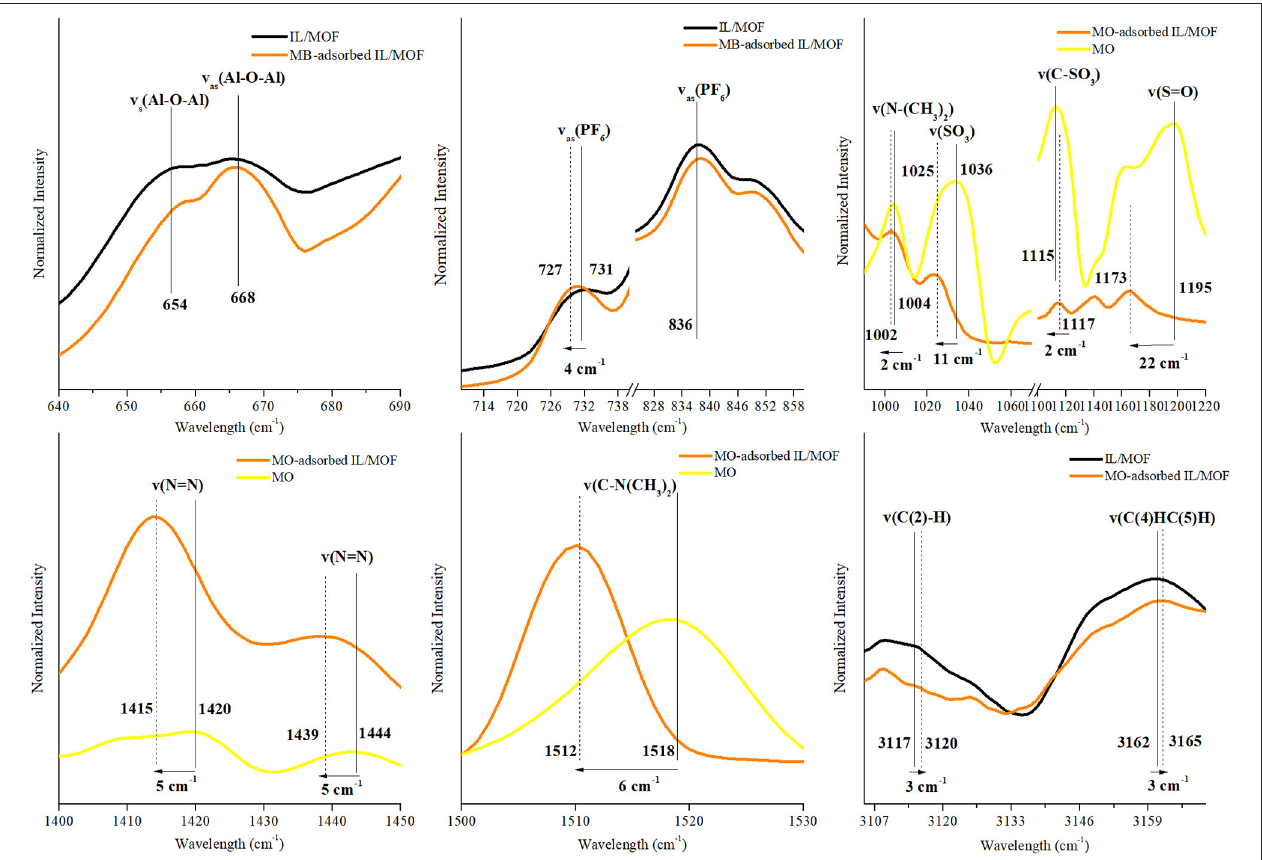
FIGURE 8 | Changes in the characteristic FTIR peaks of [BMIM][PF 6 ]/MIL-53(Al) composite and MO after MO adsorption. FTIR, Fourier transform infrared; MO, methyl